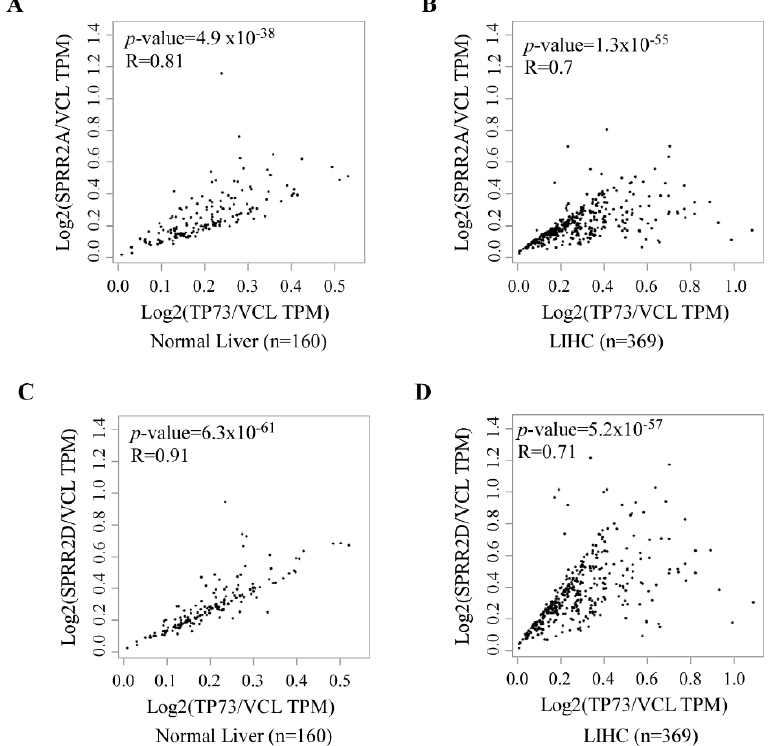
Figure 4. Correlation of p73 and SPRR2A/2D expression in normal and neoplastic tissues. ( A , B ) p73 expression is associated with SPRR2A expression in normal liver tissues ( A ) and liver hepatocellular carcinomas ( B ). The analysis was performed using the GEPIA2 database (http://gepia2.cancer-pku.cn/#correlation, accessed on 16 November 2020). Statistical analysis suggests a strong correlation between p73 and SPRR2A expression in normal liver tissues (Pearson’s r = 0.81) and cancerous liver tissues (Pearson’s r = 0.7). ( C , D ) p73 expression is associated with SPRR2D expression in normal liver tissues ( C ) and liver hepatocellular carcinomas ( D ). Statistical analysis suggests a strong correlation between p73 and SPRR2D expression in normal liver tissues (Pearson’s r = 0.91) and cancerous liver tissues (Pearson’s r =